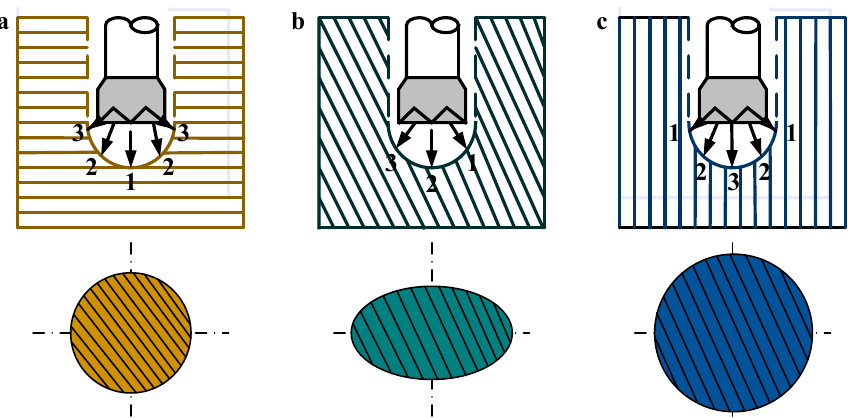
Figure 13. Hole breakage of bit and formation in different directions. ( a )—The bit is perpendicular to the layer; ( b )—The bit is oblique to the layer; ( c )—The bit is parallel to the layer. 1—Crushing speed perpendicular to the layer; 2—Crushing speed at oblique intersection with the layer; 3—Crushing speed parallel to the layer.